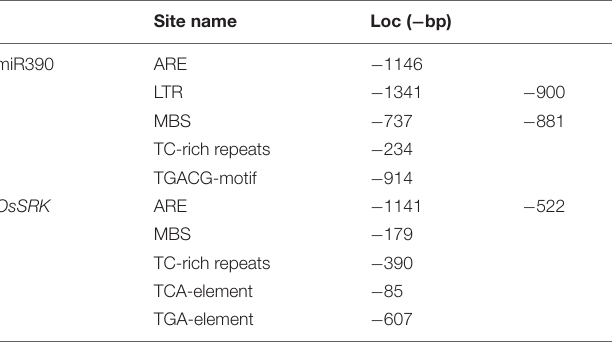
TABLE 1 | Stress-related cis -elements analysis of miR390 and its target